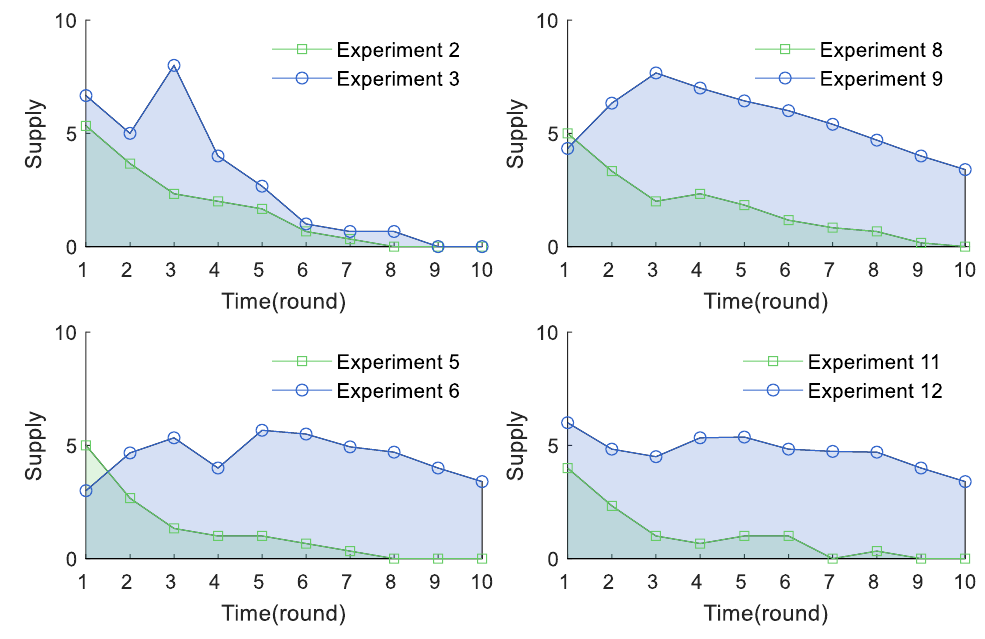
Figure 7. Effects of rewards and punishments on supply. Table 7. Mann – Whitney U test of the effects of rewards and punishments on supply.